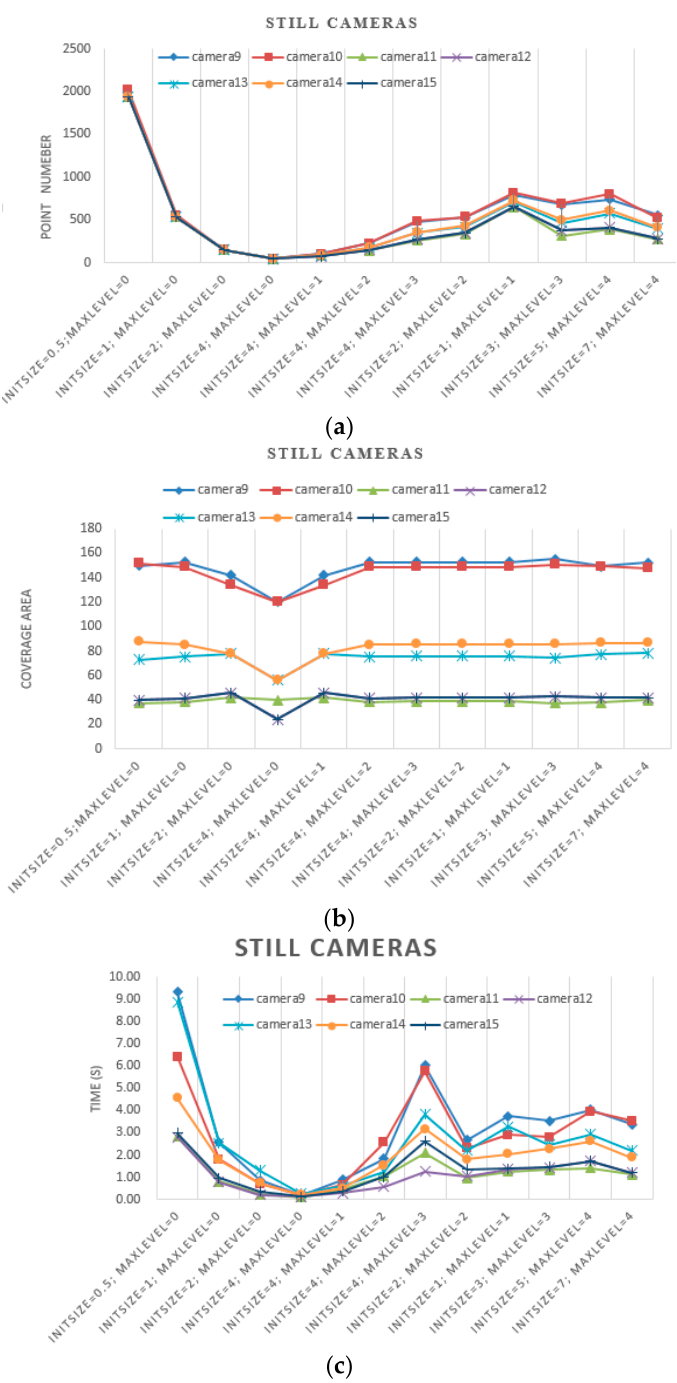
Figure 14. Results for still cameras ( a ) point number; ( b ) coverage area; ( c ) time-consuming.